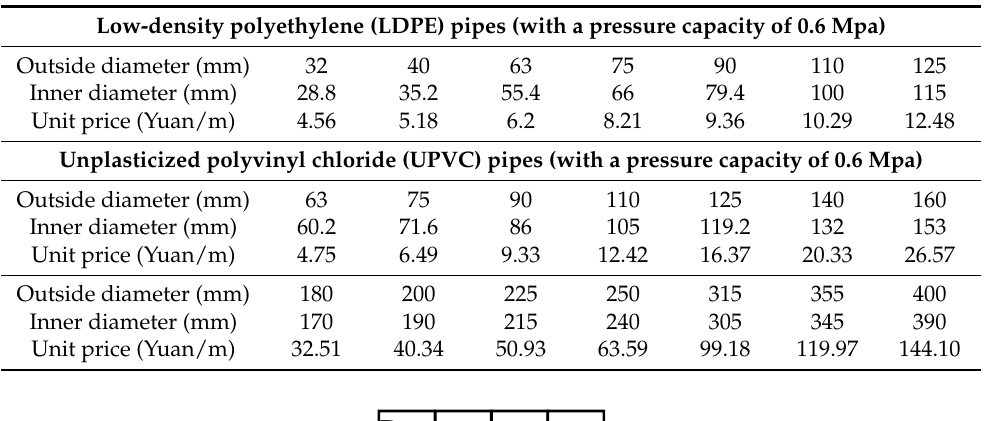
Figure 5. Sketch of a branch pipe.